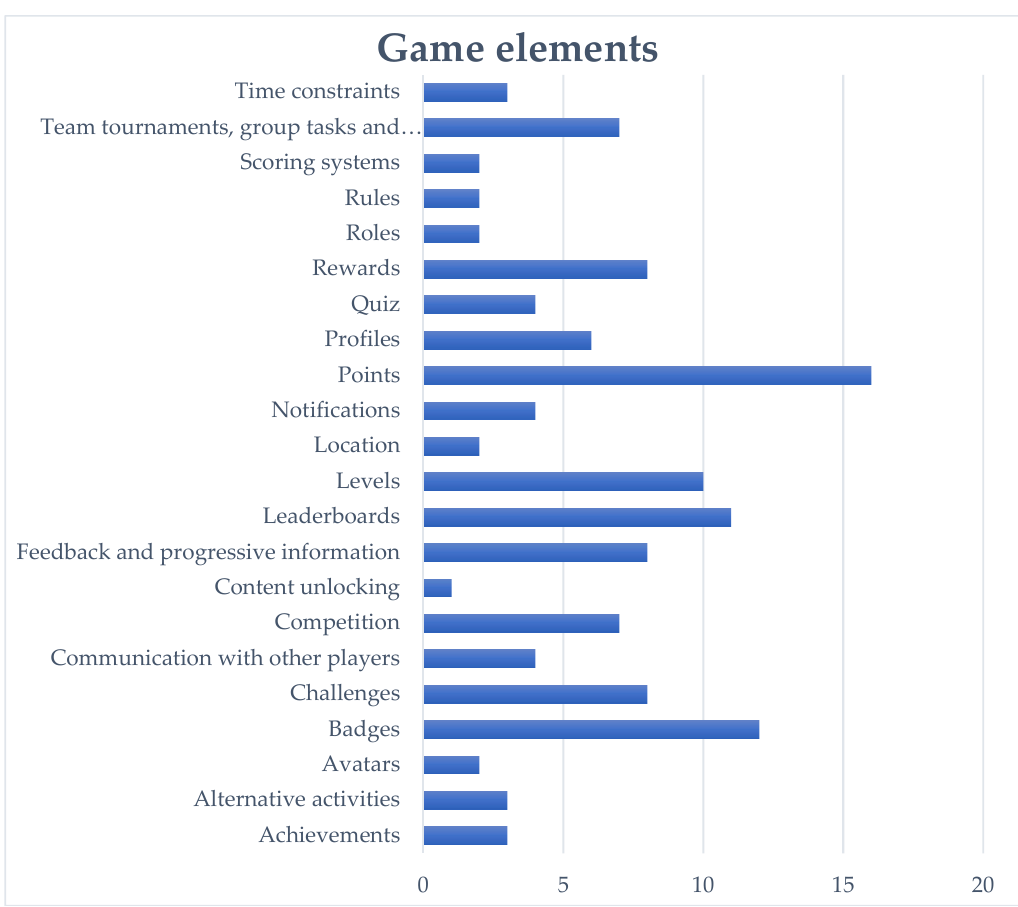
Figure 1. Game elements and number of works mentioned.